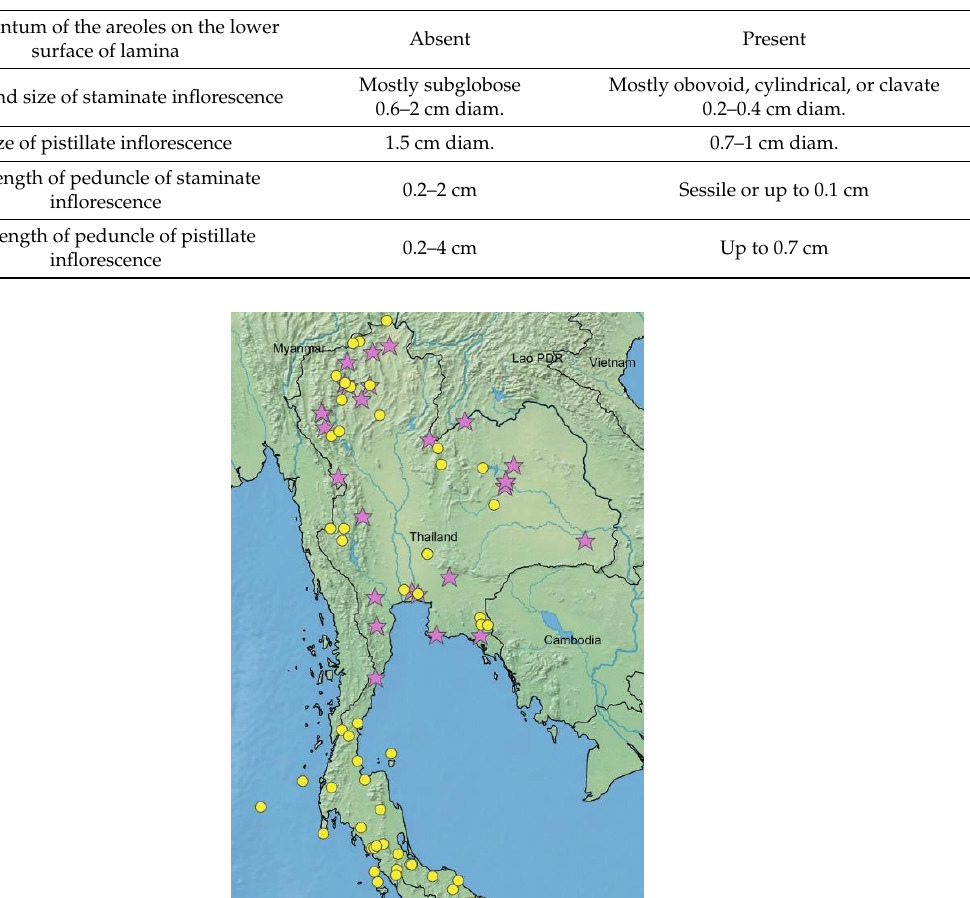
Figure 2 . Distribution map of A. lacucha (yellow-circle) and A. thailandicus (pink-star) in Thailand.